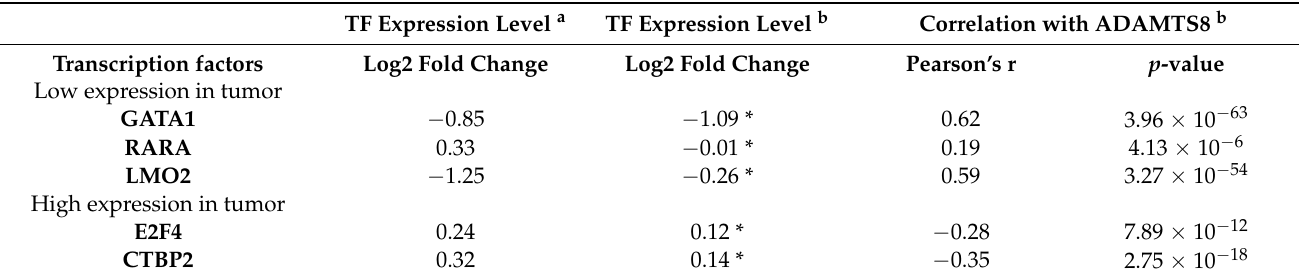
Table 1. Survival significance of curated co-association transcription factors and their correlations with targeted ADAMTS8.